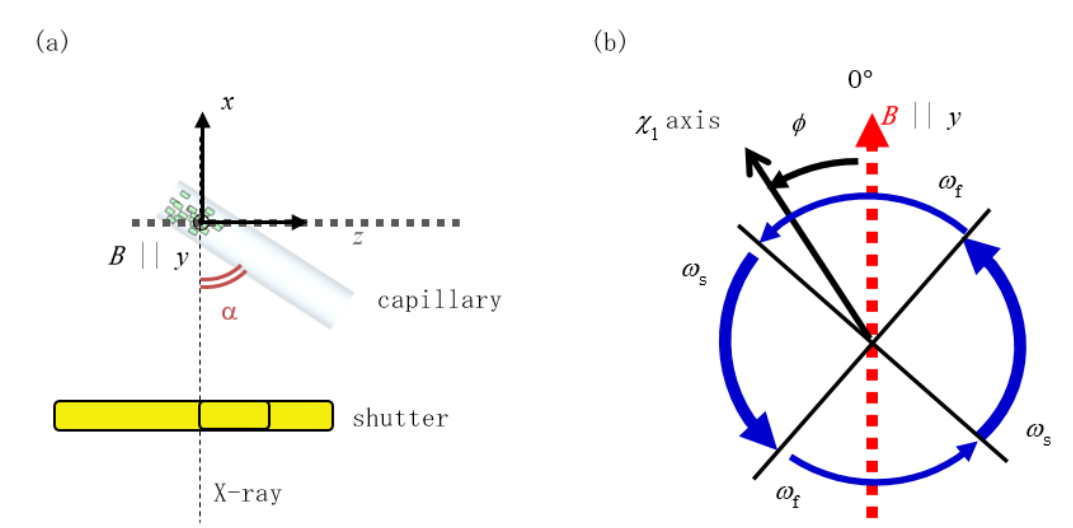
Figure 1. Definition of the angles α and φ . ( a ) α is the angle between the capillary axis and the X-ray beam ( || x ). The magnetic field B is parallel in the y direction. ( b ) φ indicates the direction of the χ 1 axis that is rotating with the capillary.